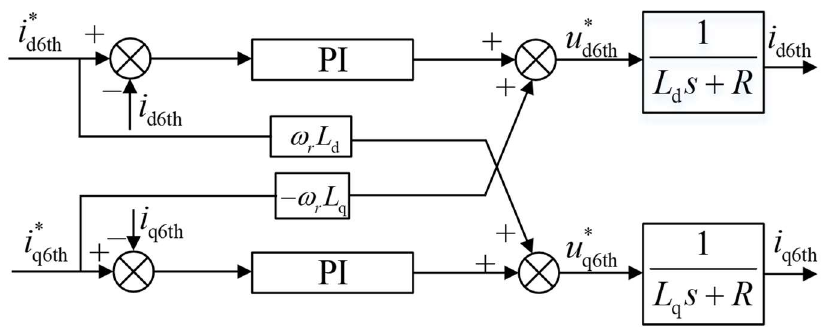
Figure 9. Block diagram of the 6th-order harmonic suppression. PI: Figure 9 . Block diagram of the 6th-order harmonic suppression. PI: proportional–integral.